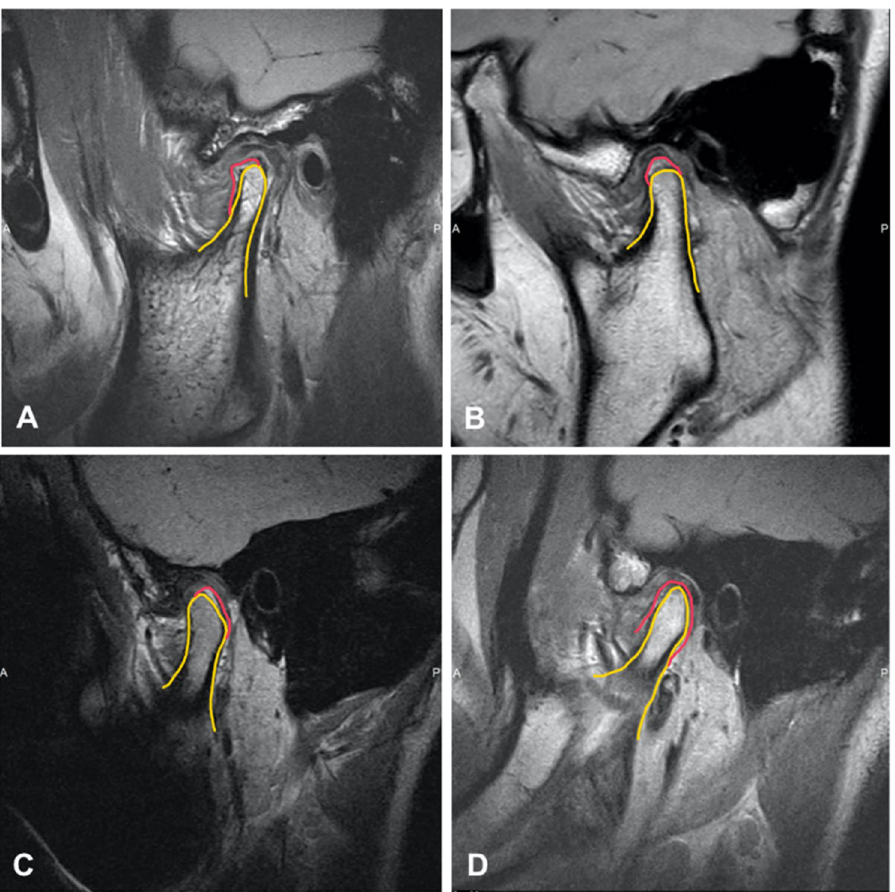
Figure 1. Condylar new bone formation was found on different position. ( A ) Anteriorslope of condyle. ( B ) On the top of condyle. ( C ) Posterior slope of condyle. ( D ) Around condyle (yellow line: condyle cortical bone outline; red line: new bone outline).